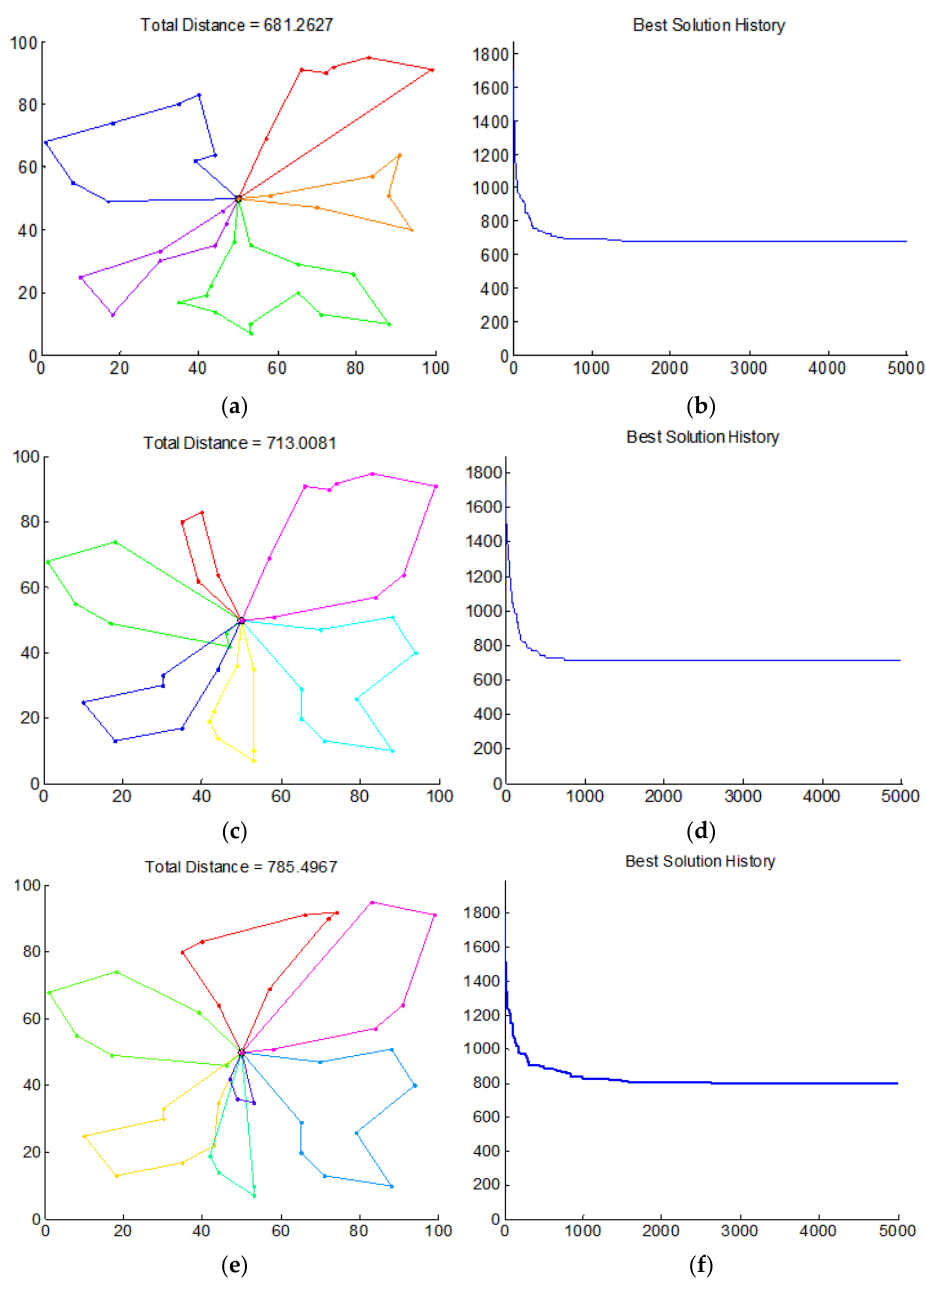
Figure 6. The distribution sequence, using the improved GA, ( a , b ) for 5 vehicles, ( c , d ) for 6 vehicles, and ( e , f ) for 7 vehicles. For ( a , c , e ), the 𝑥 - and 𝑦 -coordinates correspond to a position on a map. For ( b , d , f ), the 𝑥 -coordinate corresponds to the number of generation, and the 𝑦 -coordinate corresponds to the total distance in km.